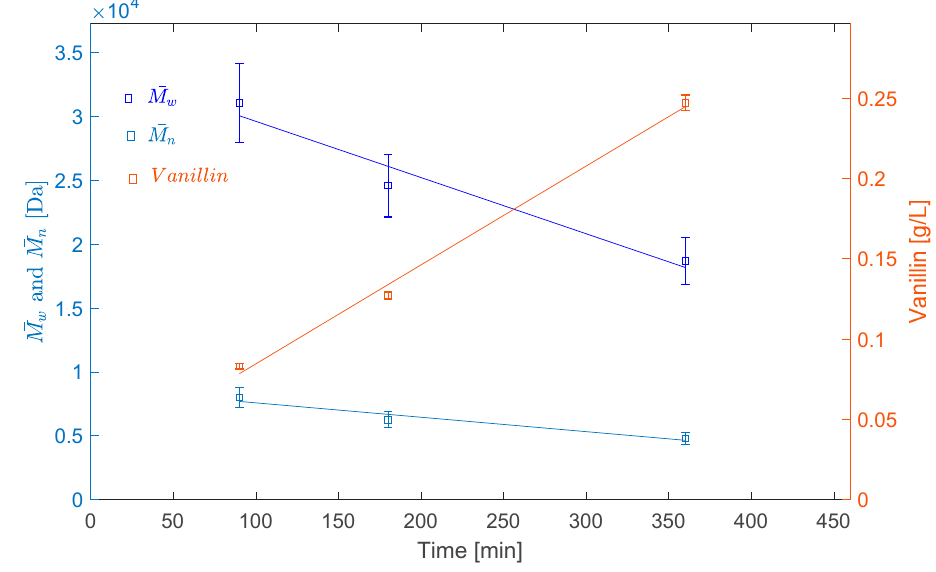
Figure 6. Effects of reaction time on the LS average molecular weight and vanillin concentration in the solutions.